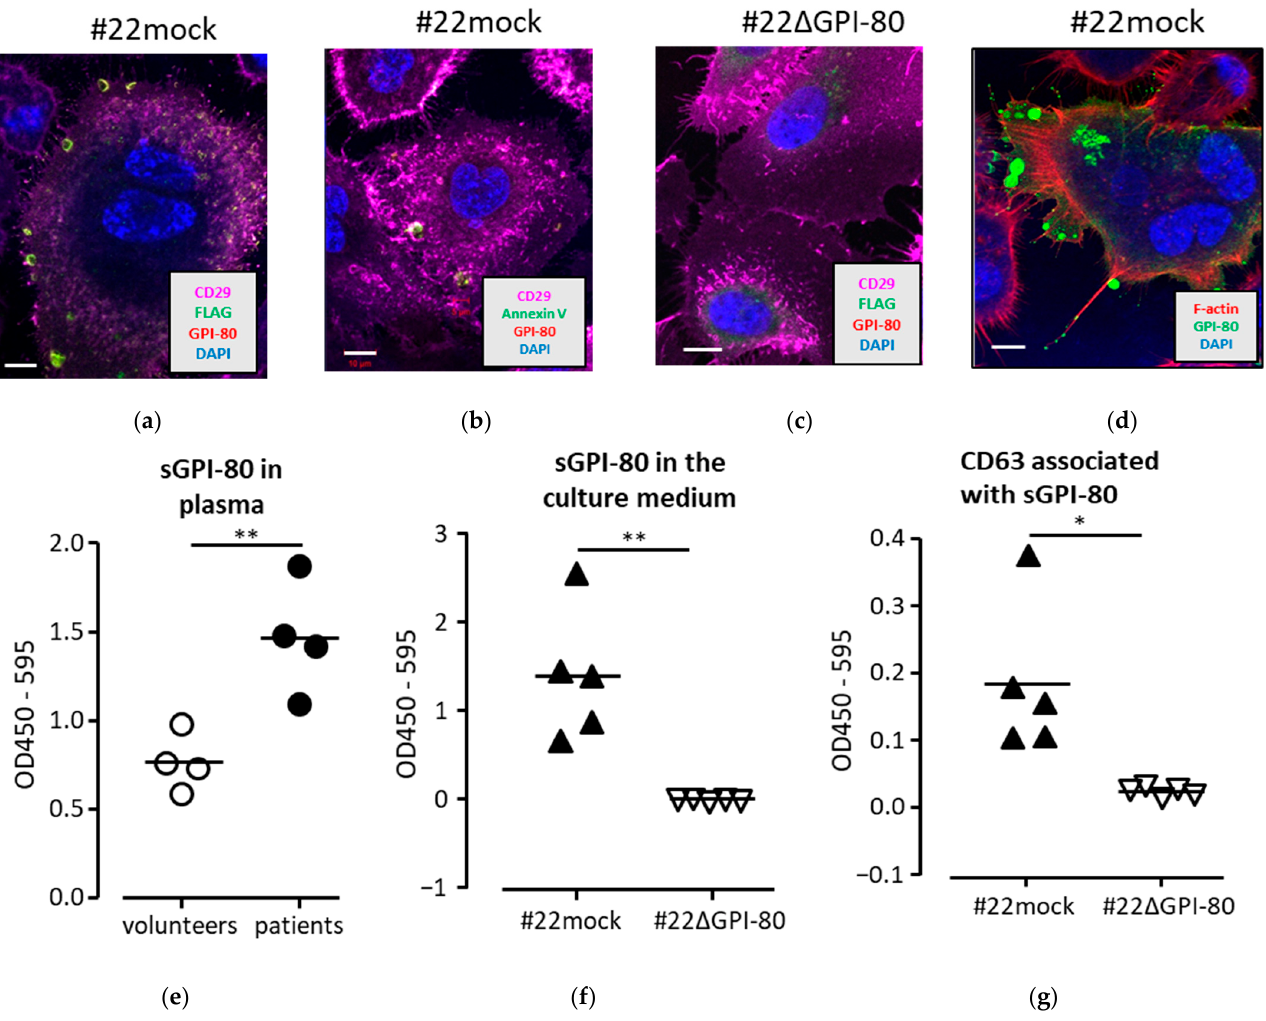
Figure 1. Localization of GPI-80 on PC3 transformant. ( a – d ) GPI-80 was observed by confocal microscopy. Cells (#22mock ( a ) and #22 Δ GPI-80 ( c )) were stained with anti-CD29 mAb (pink), anti-FLAG mAb (green), anti-GPI-80 mAb (yellow), and DAPI (blue). Cells (#22mock ( b )) were also stained with anti-CD29 mAb (pink), anti-GPI-80 mAb (yellow), DAPI (blue), and Annexin V (green). ( d ) After fixation and incubation with unlabeled anti-GPI-80 mAb (3H9) and FITC-conjugated anti-mouse antibody (green), the permeabilized #22mock cells were stained with phalloidin (red) to detect F-actin. Data are representative of results from more than three independent experiments. Scale bar, 10 μ m. ( e – g ) Detection of soluble GPI-80 by sandwich ELISA. ( e ) Soluble GPI-80 level in the plasma of healthy volunteers (four volunteers; open circle) and the prostate cancer patients (four patients; closed circle) was detected by paired anti-GPI-80 mAbs, 3H9 and 4D4. ( f ) Soluble GPI-80 levels in the conditioned medium of #22mock (closed triangle) and #22 ∆ GPI-80 (open triangle) cells were also measured using paired anti-GPI-80 mAbs. ( g ) To detect the colocalization of GPI-80 with CD63, conditioned media from #22mock (closed triangle) and #22 ∆ GPI-80 (open triangle) were analyzed using anti-GPI-80 mAb (3H9) paired with anti-CD63 mAb (8A12). These culture media were independently collected from confluent cells after 4 days. Statistical significance was calculated using two-tailed unpaired Student’s t -test (*, p < 0.05; **, p <